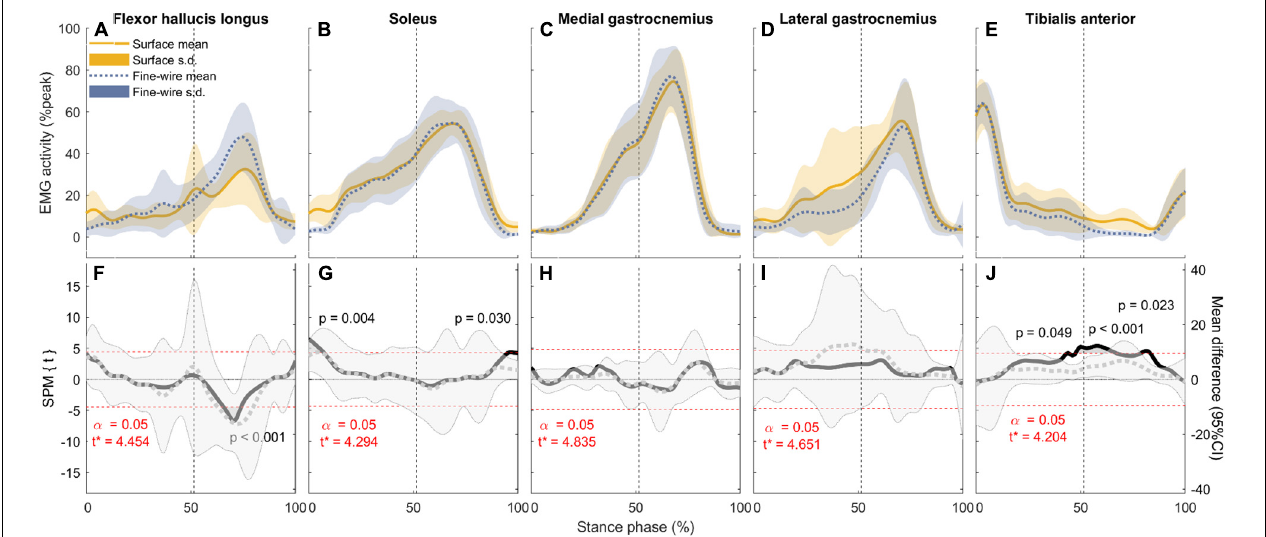
FIGURE 3 | Electromyography (EMG) activity (mean and standard deviation) of each muscle ( A–E : normalised to peak activity in preferred speed walking, %peak) and the corresponding comparisons between surface and intramuscular EMG recordings (F–J) in the stance phase of slow walking (1.01 ± 0.13 m s − 1 ). Vertical dotted lines represent the beginning of push-off. Panels (F–J) : SPM{ t } statistics for two-tailed t -tests (solid black lines, left y -axis), and mean difference with 95% confidence intervals (grey dotted lines with shaded areas). Dashed red lines are critical thresholds ( t ∗ ) calculated for α significance level defining supra-threshold clusters for SPM{ t } trajectories. P- values were calculated for each supra-threshold cluster.